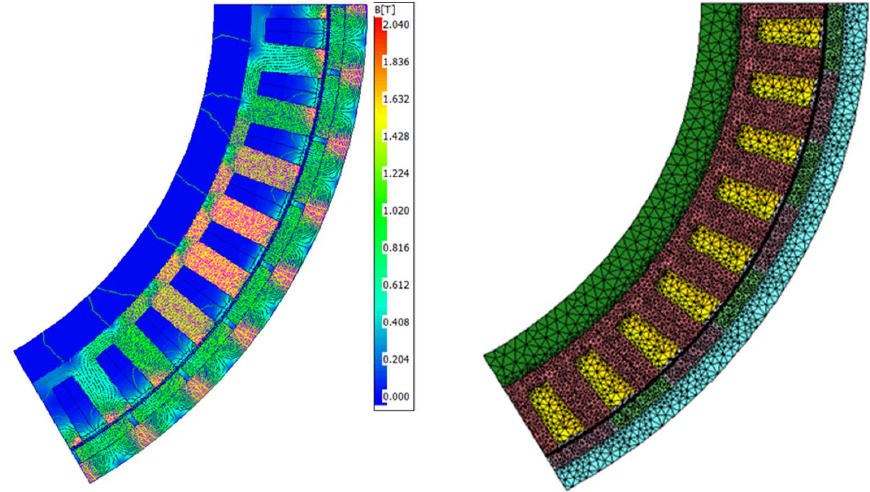
Figure 4. Calculated magnetic induction distribution from the permanent magnets.